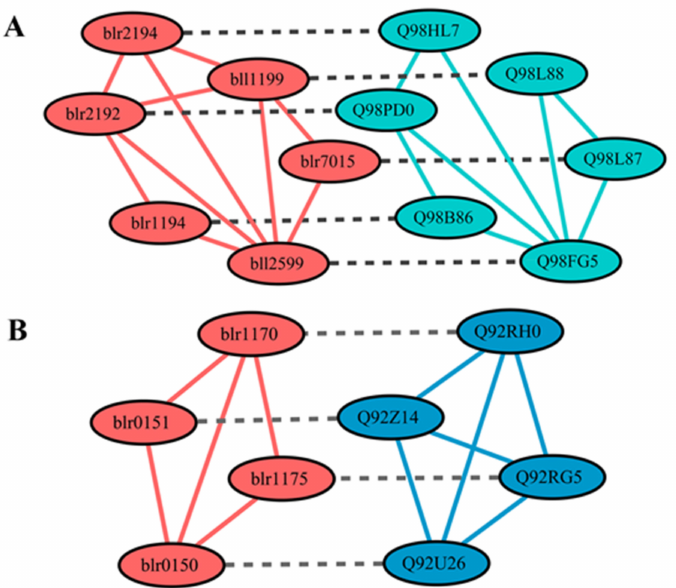
Figure 5. Examples of conserved PPI modules identified by GASOLINE. ( A ) The conserved PPI module related to chemotaxis was identified from the comparison between the global PPI network of B. diazoefficiens USDA110 (red) and M. loti (green). ( B ) The conserved PPI module related to cytochrome C oxidase was identified from the comparison between the SNF PPI network of B. diazoefficiens USDA110 (red) and S. meliloti (blue). Solid lines represent the PPI within each module and dashed lines represent correspondence (homology) relationship between